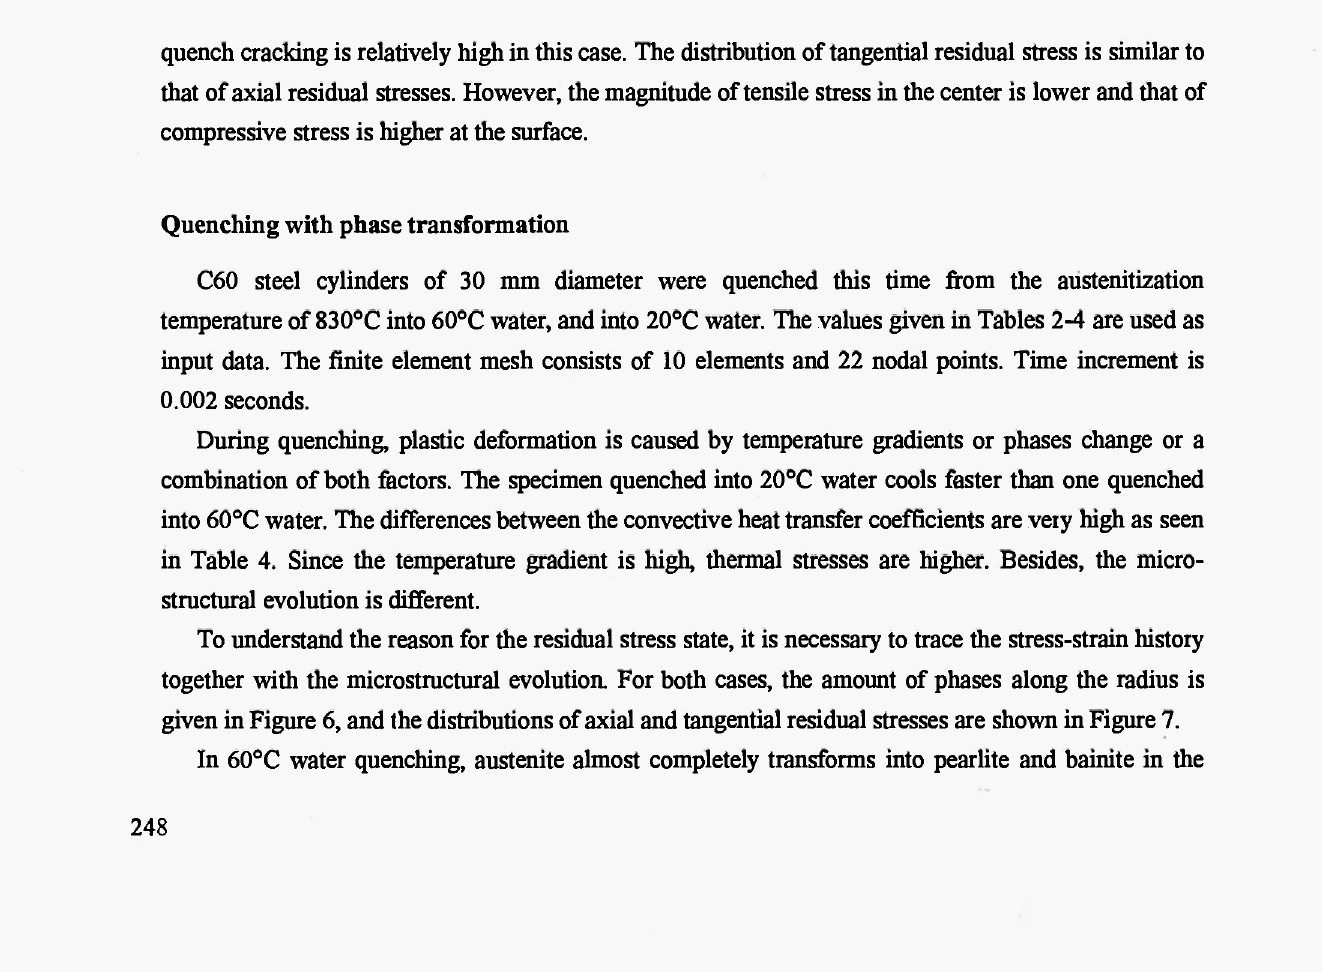
Fig. 4: Cooling curves of 20°C and 60°C water quenching from 720248C for C60 steel cylinder of 30 mm